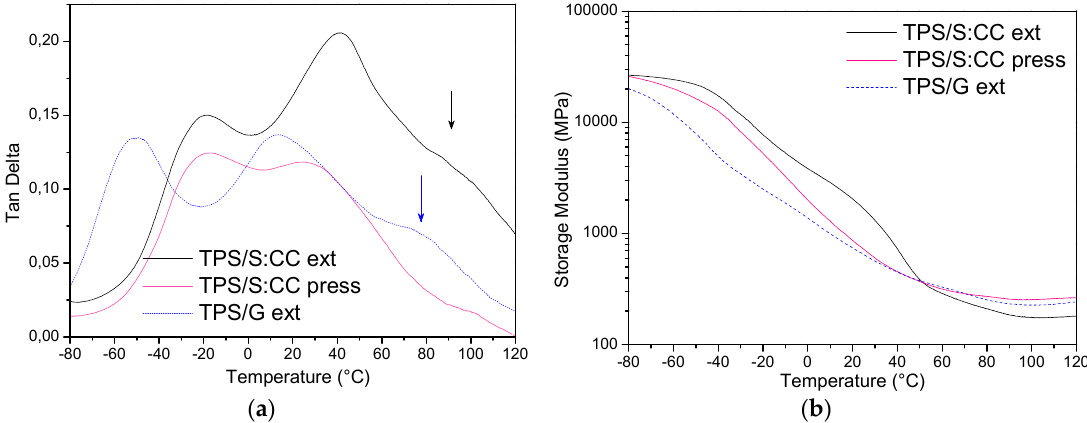
Figure 5. Tan delta and storage modulus for TPS / S:CC 2:1 films obtained by various processing methods (thermocompression-press and thermocompression after extrusion-ext) and for TPS / G after extrusion. ( a ) tan δ curves; ( b ) Storage modulus